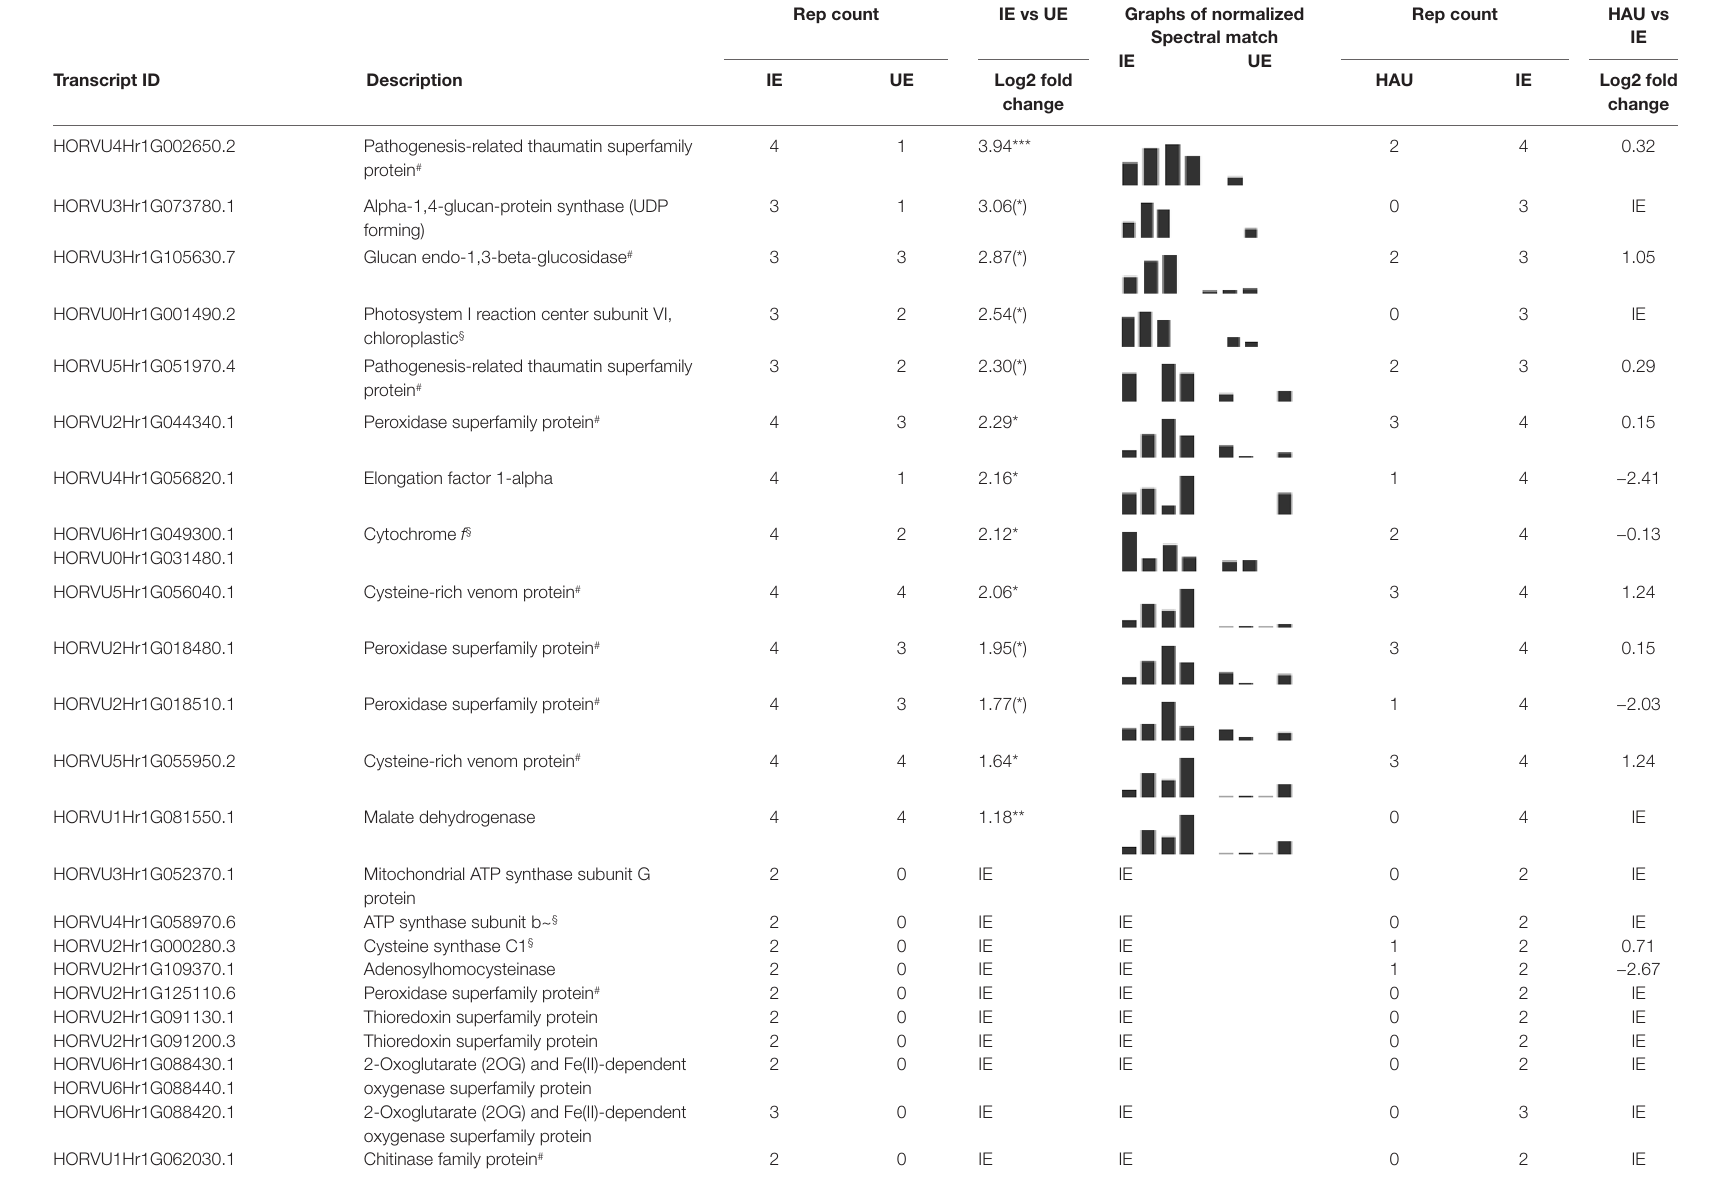
TABLE 1 | List of differentially abundant proteins (DAPs) with a significant increase in relative abundance in IE when compared with UE (IE vs UE comparison). The number of replications per experimental set (Rep count) and log 2 fold change (average of spectral count) or exclusivity in one set are reported for both HAU vs IE and IE vs UE